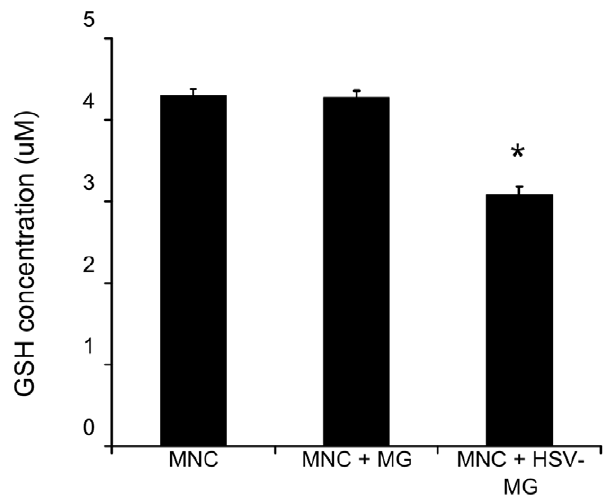
Figure 4. Reduced GSH production in MNCs exposed to HSV- stimulated microglia. Purified murine microglia obtained from neonatal Balb/c mice were infected with HSV-1 at 2 MOI for 90 min ( + HSV 2 Mg) and added at a 1 to 5 microglia: neural cell ratio to MNC. Cultures were maintained for 48 h before quantification of GSH concentration ( m M). Unstimulated microglia ( + Mg) and MNC only cultures were used as controls. Statistical significance was tested using an ANOVA single factor with PLSD Post-hoc analysis (StatView 5). *p # 0.0001.